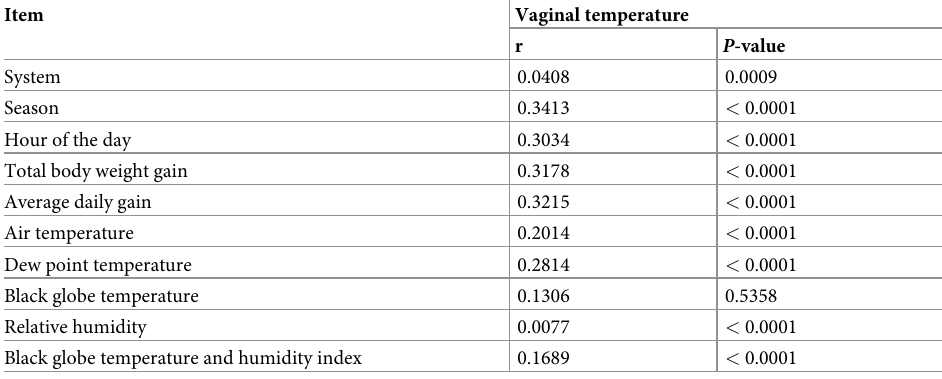
Table 1. Pearson correlation coefficients (r) between vaginal temperature from Nellore heifers with seasons, hours of the day, animal performance and climatic elements in systems with different microclimatic conditions. Item Vaginal temperature